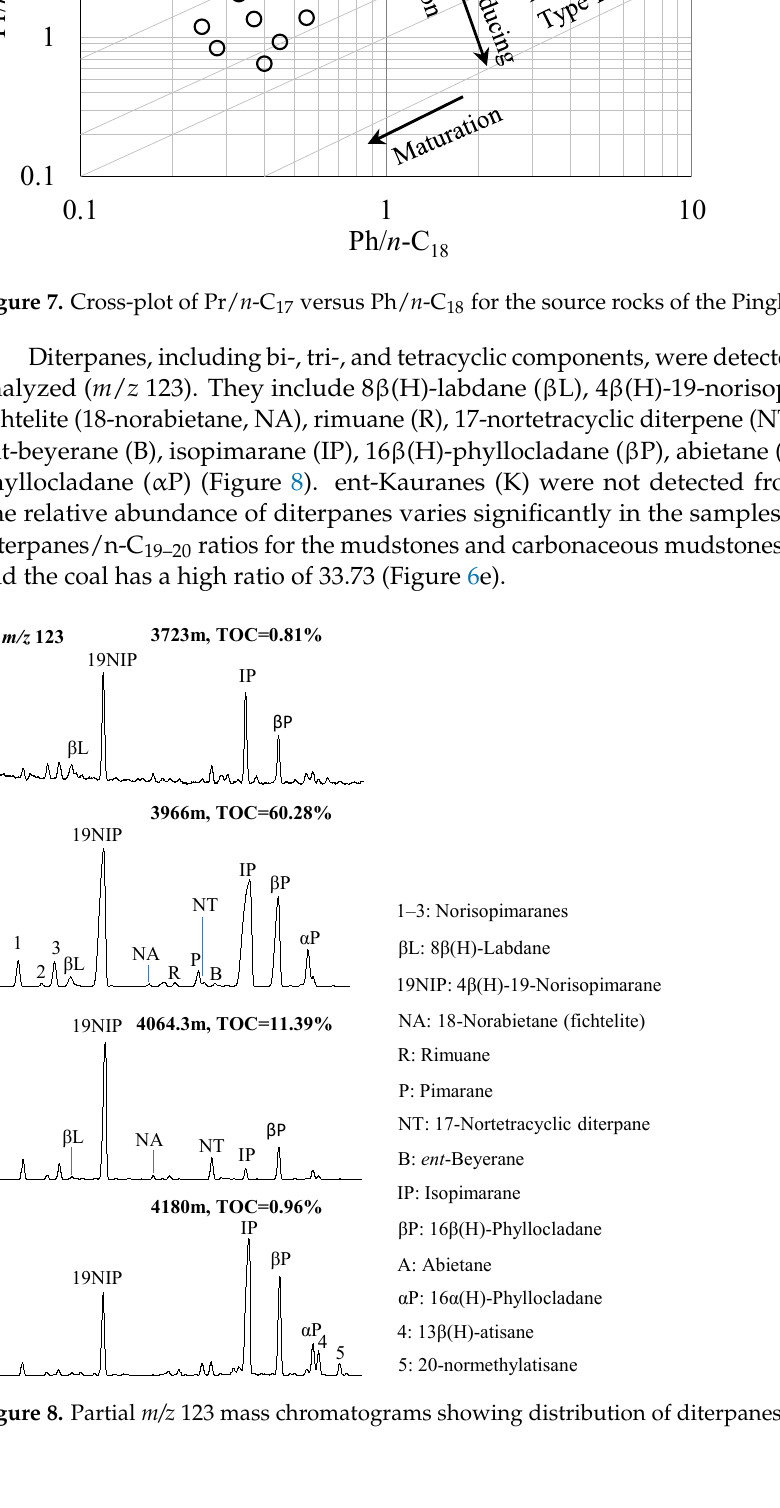
Figure 7. Cross-plot of Pr/ n -C 17 versus Ph/ n -C 18 for the source rocks of the Pinghu Formation.